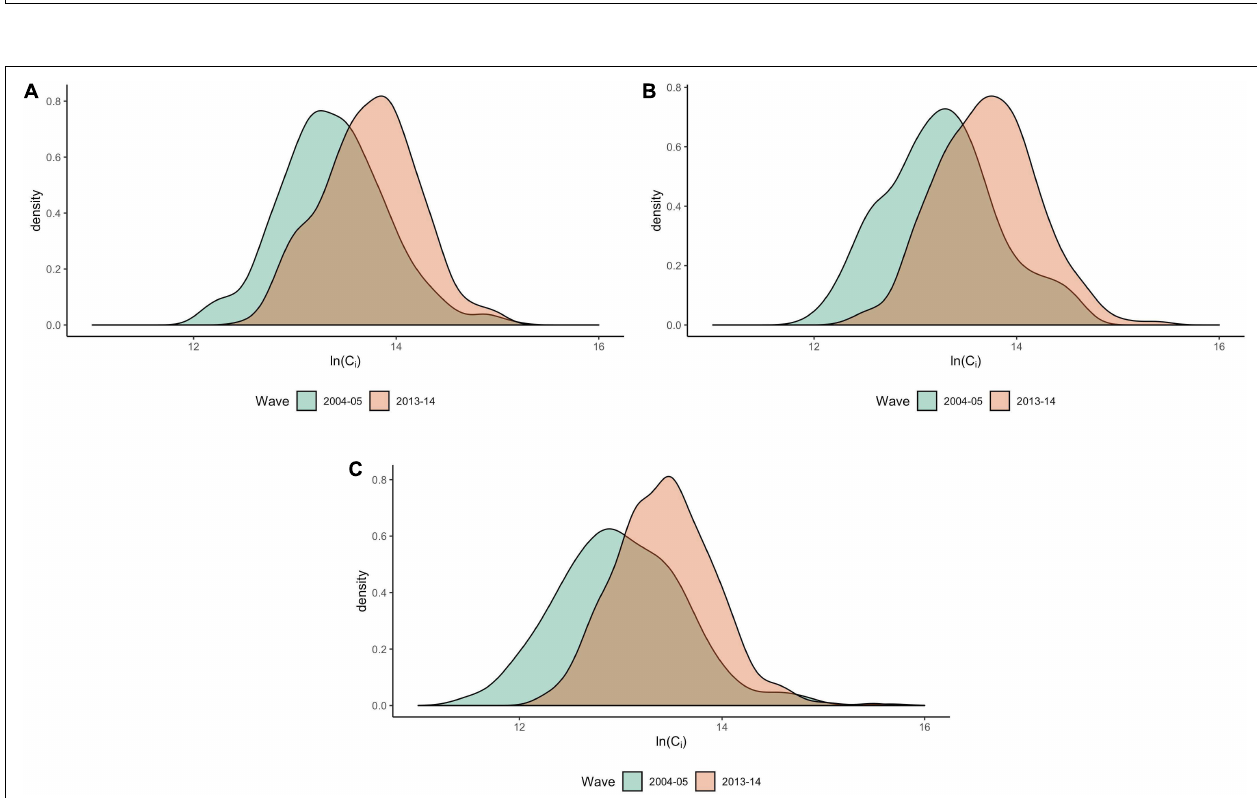
FIGURE 3 | Allocation of land to trees on farms across survey waves. n = 1,395 rural households. Brown color shows overlap between two survey waves. Data source: UNPS 2005–2006 and 2013–2014.